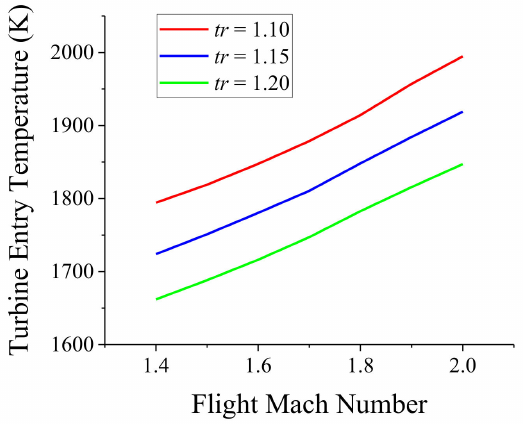
Figure 20. The Variations of Turbine Entry Temperature at the conditions of Different Throttle Ratio ( tr